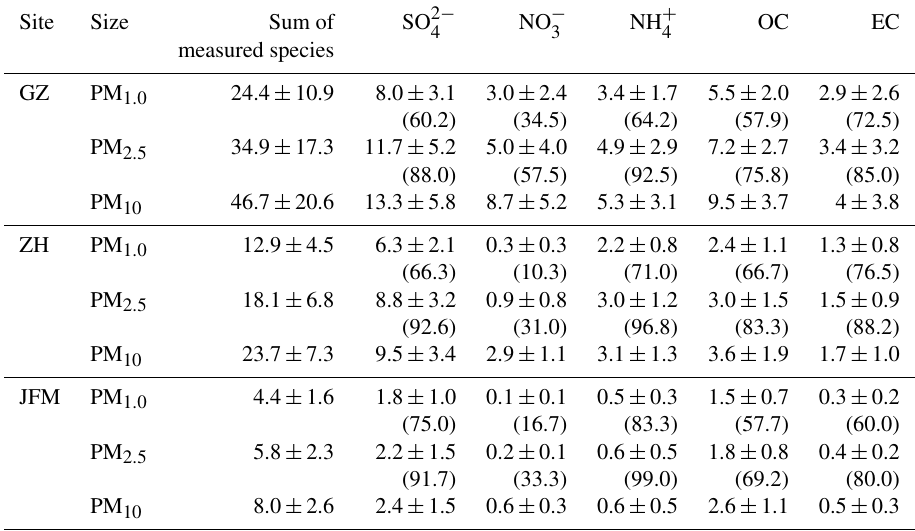
Table 1. Average concentration and standard deviation (µgm − 3 ) of chemical components in the given size-resolved particles (and their percentage of PM 10 ) at the three sites during the 2010 wet